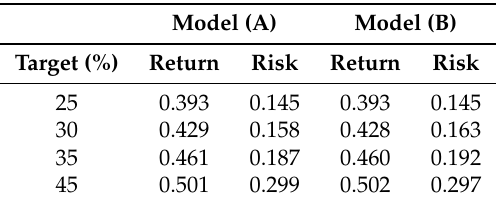
Table 2. Effect of regulating term with VCV ( Σ